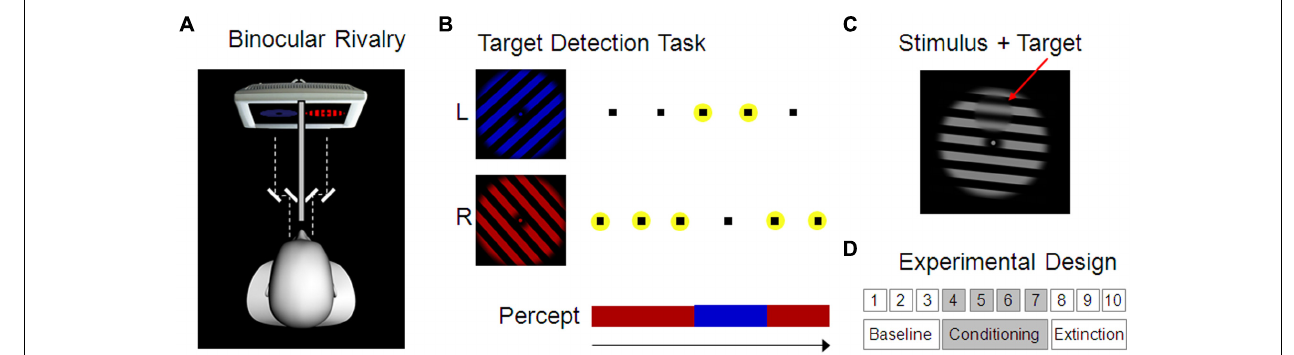
invisible. Correct responses to a target, i.e., correct identification of the target position (here indicated by a yellow circle), was therefore used to indirectly assess the current conscious perception of the participant. (C) Example of a target, i.e., a small smoothed disk upon the grating stimulus (here depicted in the top position). (D) Experimental Design comprising 10 blocks with 3 min each, separated in baseline, conditioning, and extinction blocks. During the conditioning blocks, one of the two percepts was rewarded (Experiment 1) or punished (Experiment 2) by monetary gains and losses,